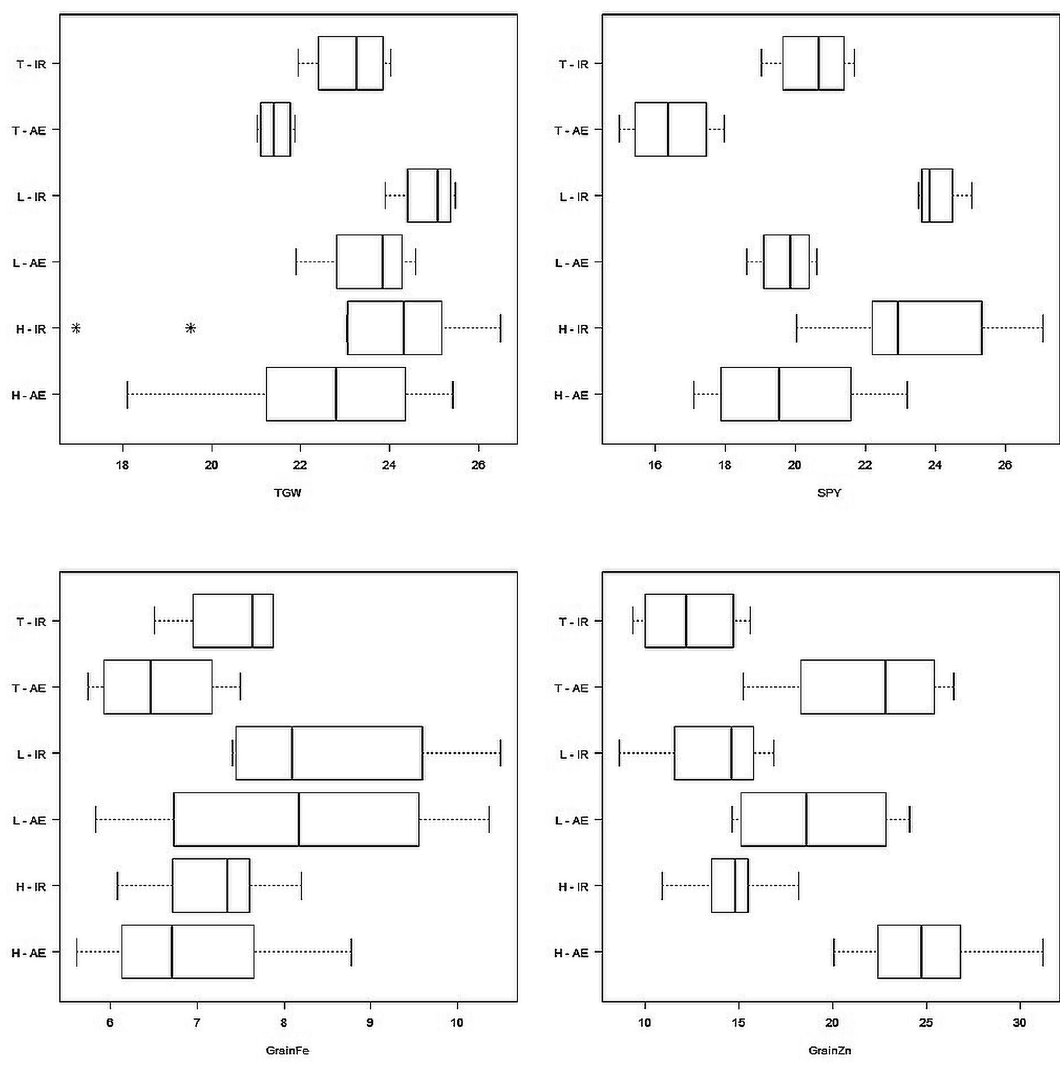
Figure 1. Hybrid and Parental Performance Per se for TGW, SPY, Grain Fe and Grain Zn content. TGW-1000 grain weight (grams); SPY-Single Plant Yield (grams); Grain Fe- Fe content in brown rice (ppm); Grain Zn-Zn content in brown rice (ppm). T-IR-Testers in Irrigated method; T-AE-Testers in Aerobic method; L-IR-Lines in Irrigated method; L-AE-Lines in Aerobic method; H-IR-Hybrids in Irrigated method; H-AE-Hybrids in Aerobic